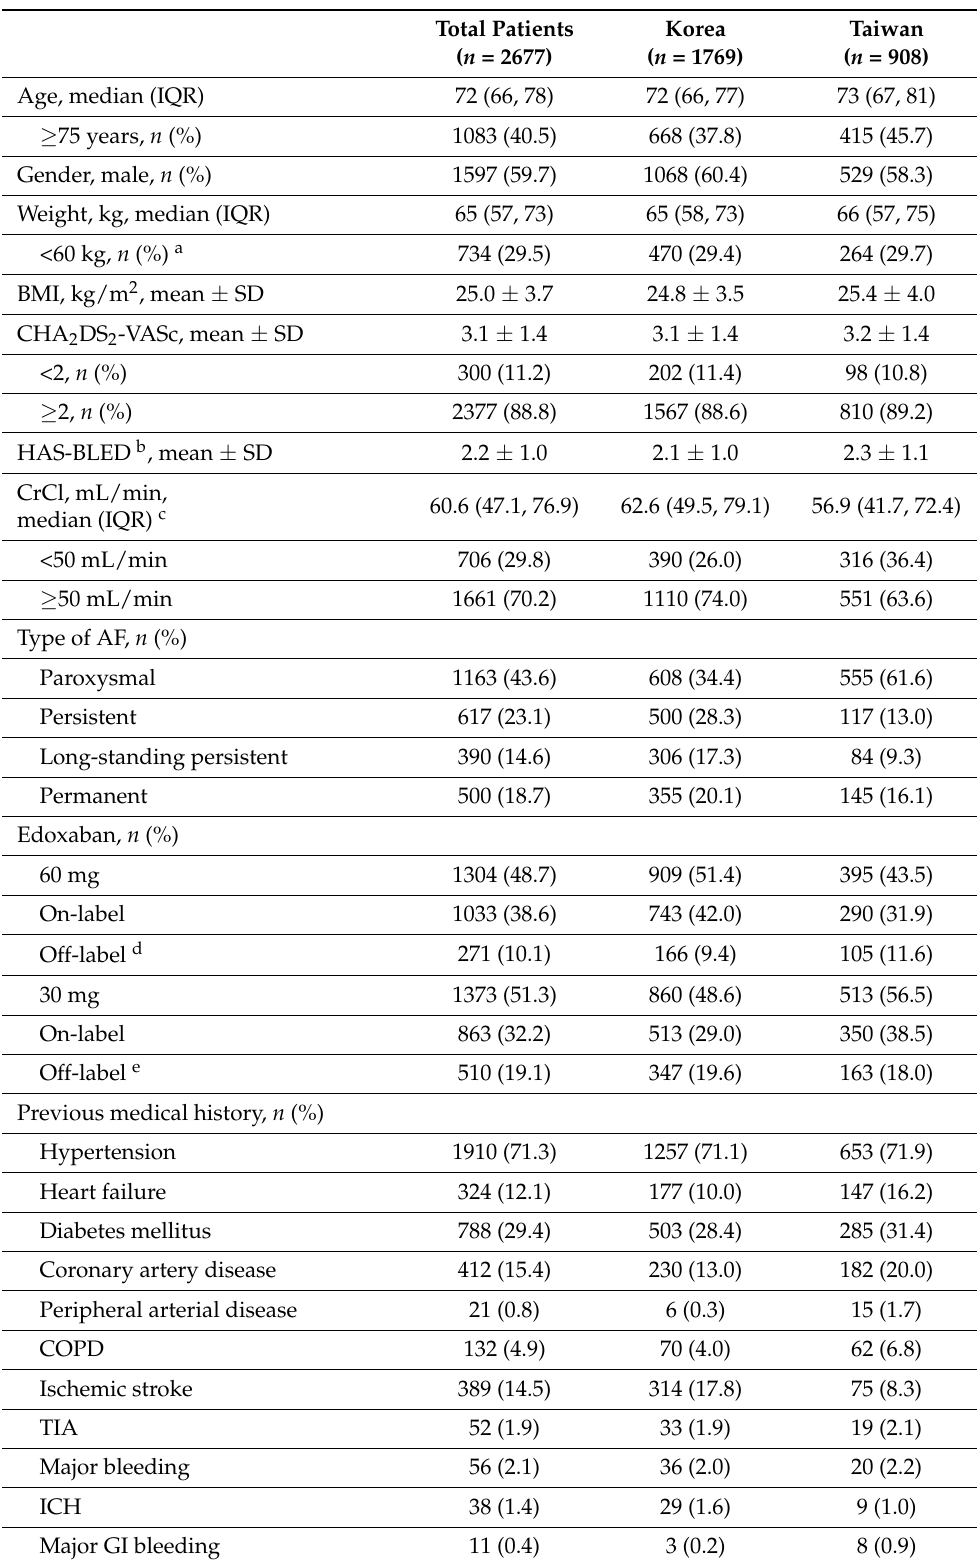
Table 1. Key baseline demographics, clinical characteristics, and previous medical